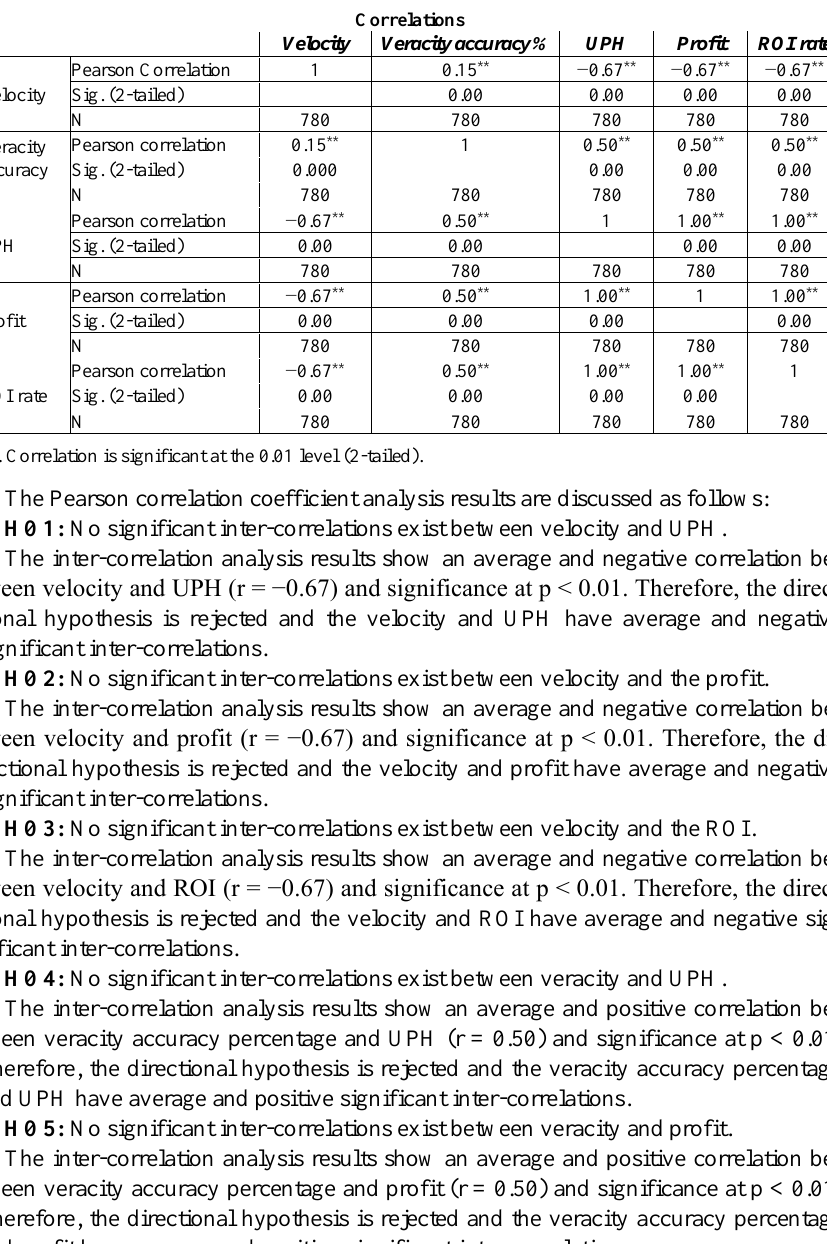
Table 5. Pearson Correlation Coefficient